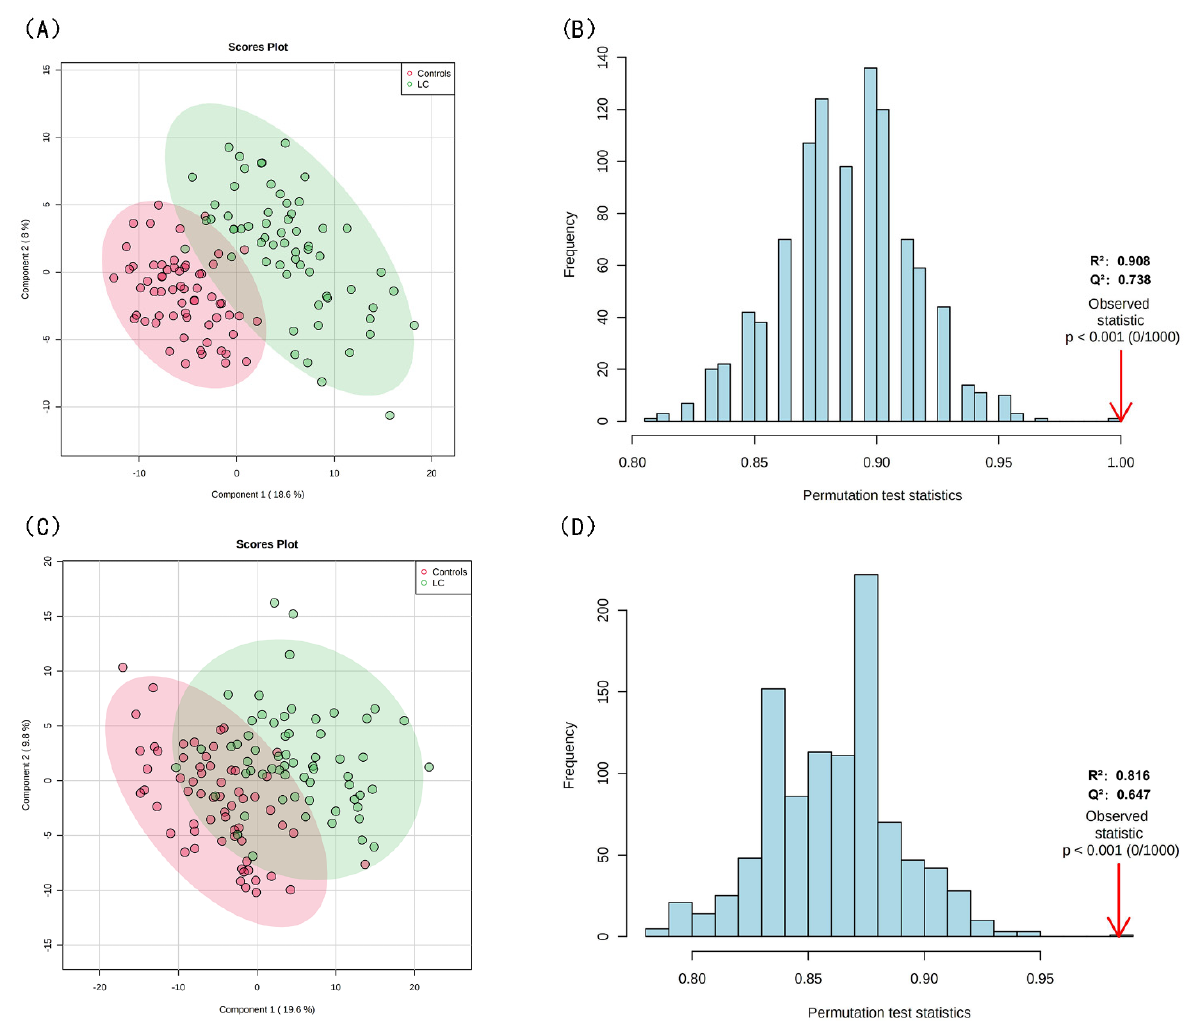
Figure 2. Results of PLS − DA ( A ) PLS − DA score plot of neg. ( B ) PLS − DA score plot of pos. ( C ) Validation of PLS − DA neg by permutation test performed with 1000 random permutations test. ( D ) Validation of PLS − DA pos by permutation test performed with 1000 random permutations test.